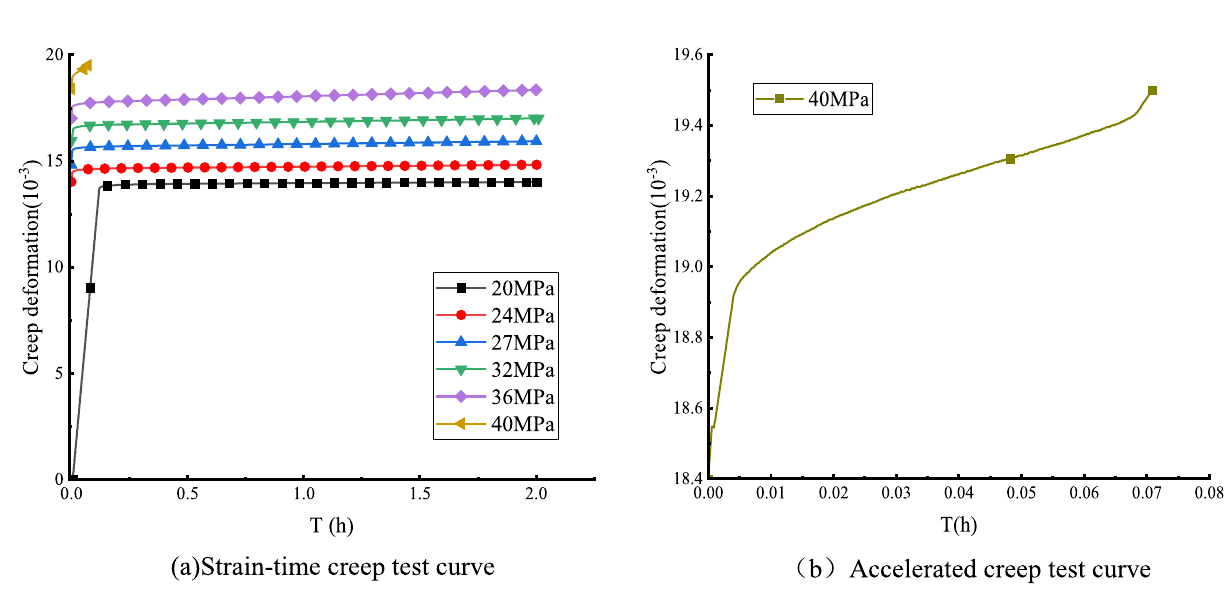
Figure 7. Uniaxial creep curve of non-destructive white sandstone